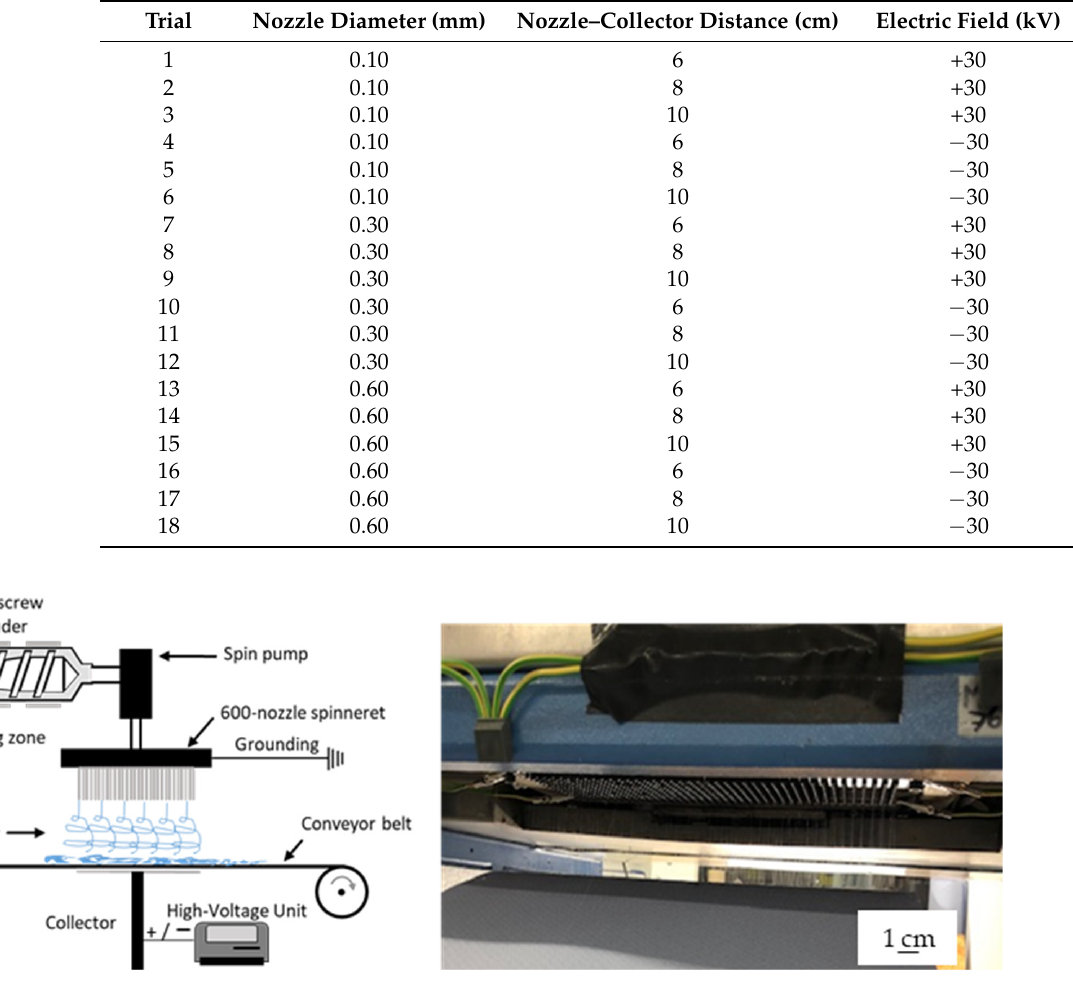
Table 1. Process parameters for the laboratory-scale melt-electrospinning experiments.